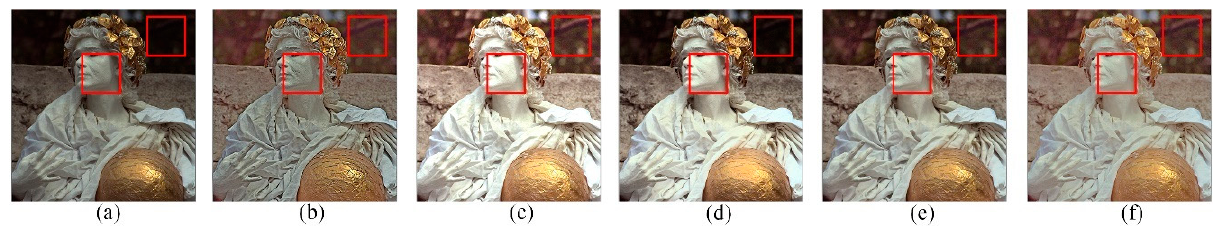
Figure 21. Buildings image. ( a ) Original image; ( b ) result of Lee’s method; ( c ) result of LIME; ( d ) result of AGCWD; ( e ) result of SIRE; ( f ) result of the proposed method.